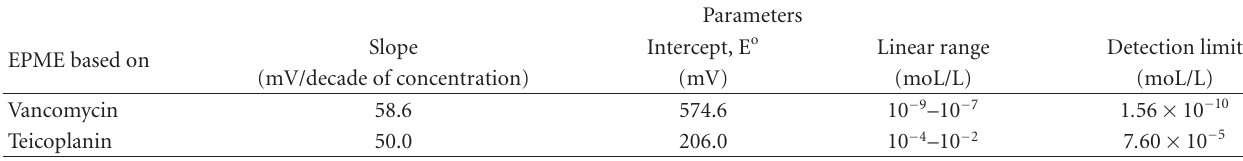
Table 1: Response characteristics of enantioselective, potentiometric membrane electrodes for L- and D-glyceric acids a